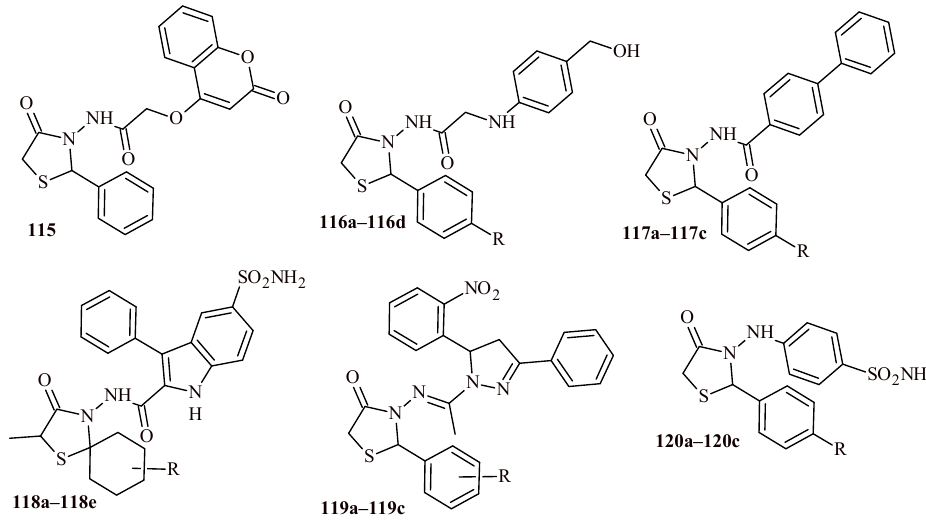
Figure 49. The structures of thiazolidin-4-ones with quinoxaline moiety. Among the 3-amino-2-aryl/alkylthiazolidin-one derivatives, Compound 115 (Figure 50) showed higher inhibitory activity (inhibition zone – 8–17 mm) than standard chlo- ramphenicol (5–15 mm) to concentration 150 µg/mL against all tested strains ( Proteus vul- garis , E. coli , K. pneumoniae , P. aeruginosa and S. aureus ) [122]. Among the series of 116a – 116d , Compound 116c with chloro substituent showed the antibacterial activity against E. coli practically equivalent to trimethoprim and better than trimethoprim against Acinetobacter baumannii and Streptococcus pyogenes [123]. The biphenylbased thiazolidine-4-ones ( 117a – 117c ) showed good antimicrobial against bacterial ( E. coli , S. aureus , B. subtilis ) and fungal ( A. niger , C. albicans ) strains, except 117c that exhibited moderate effect against fungal strains [124].